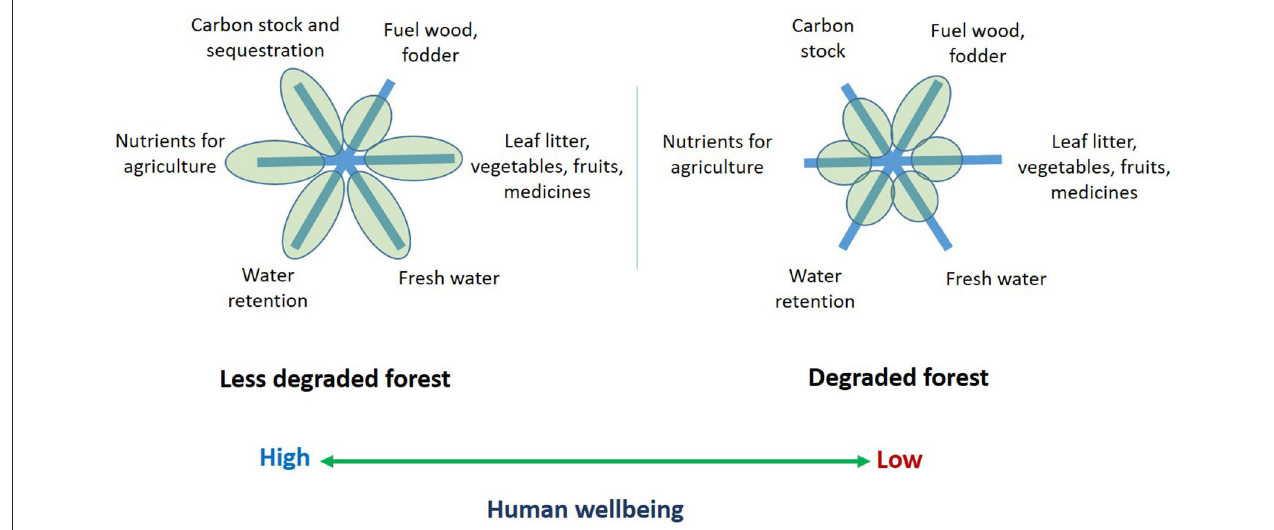
FIGURE 4 | Wellbeing indices for households located close to and away from less degraded and degraded